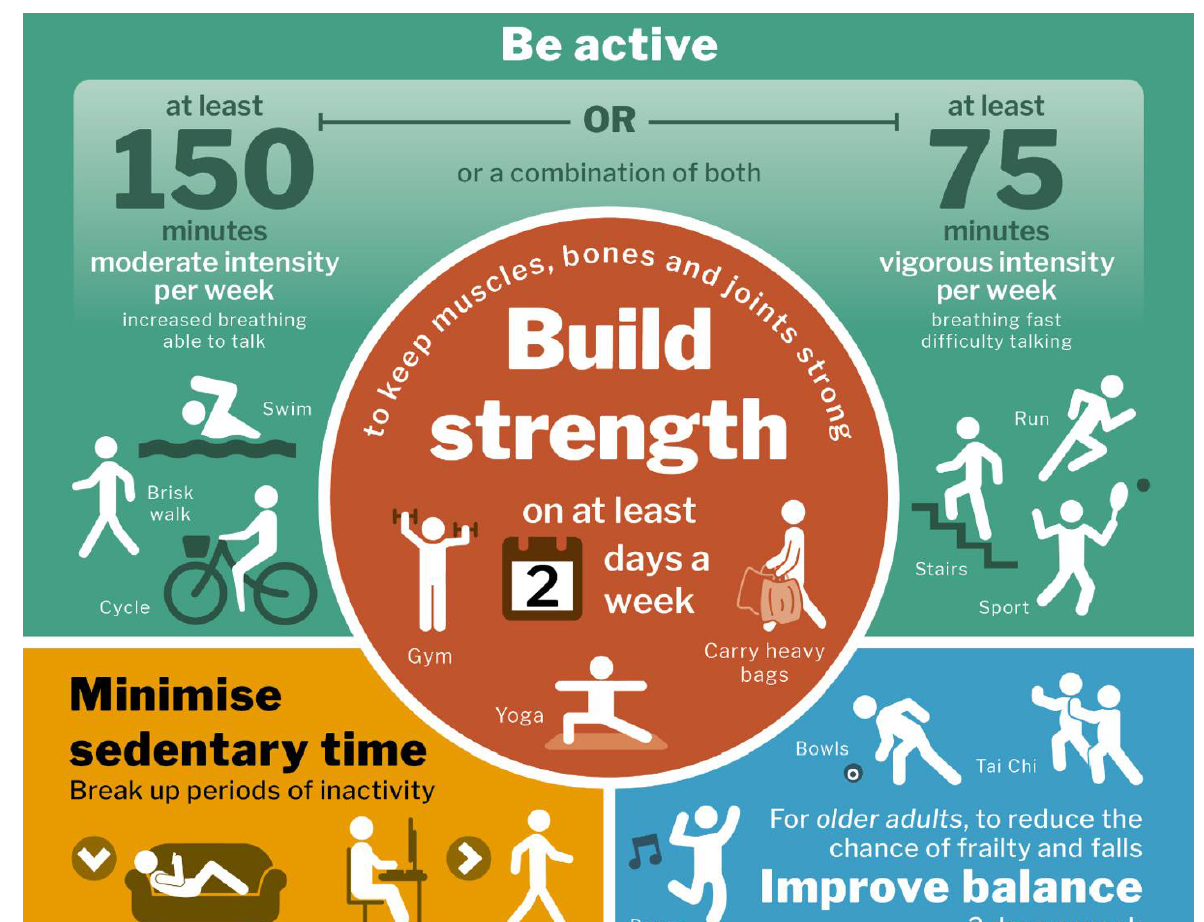
Figure 1. The 2019 United Kingdom’s Chief Medical Officers’ physical activity guidelines infographic (page 35) [13].